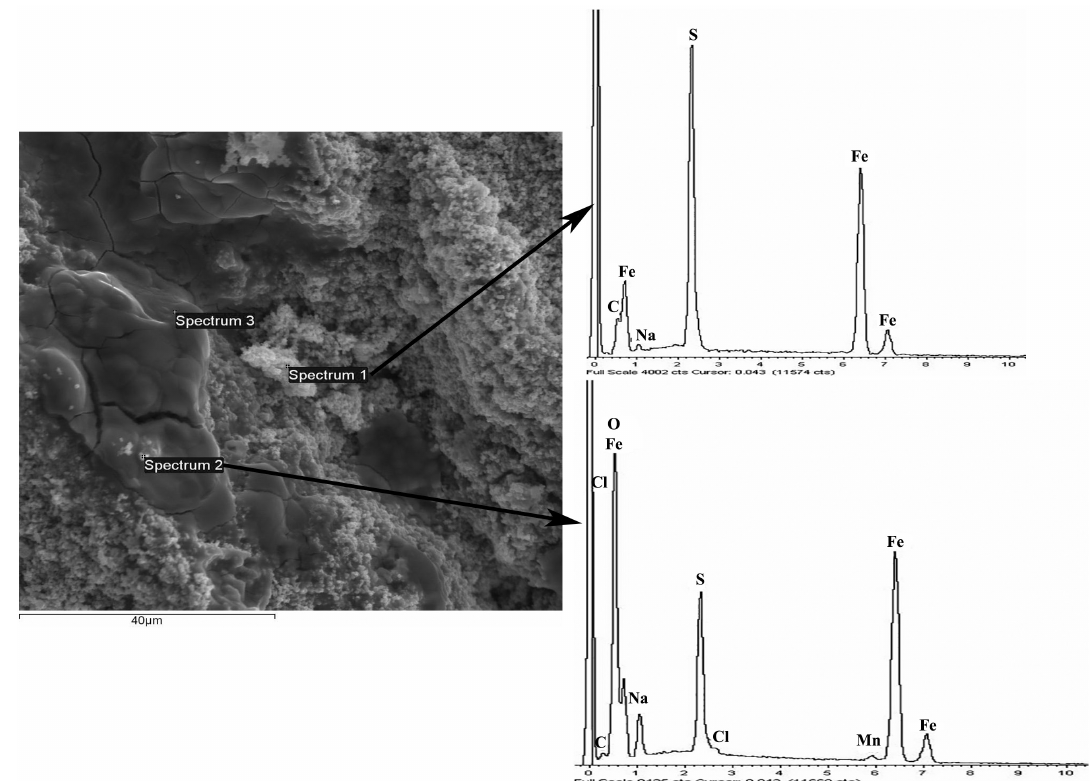
Figure 8. SEM and EDS characterization of the corrosion product film of the welded joint tested in solution 1, pH=3.0.